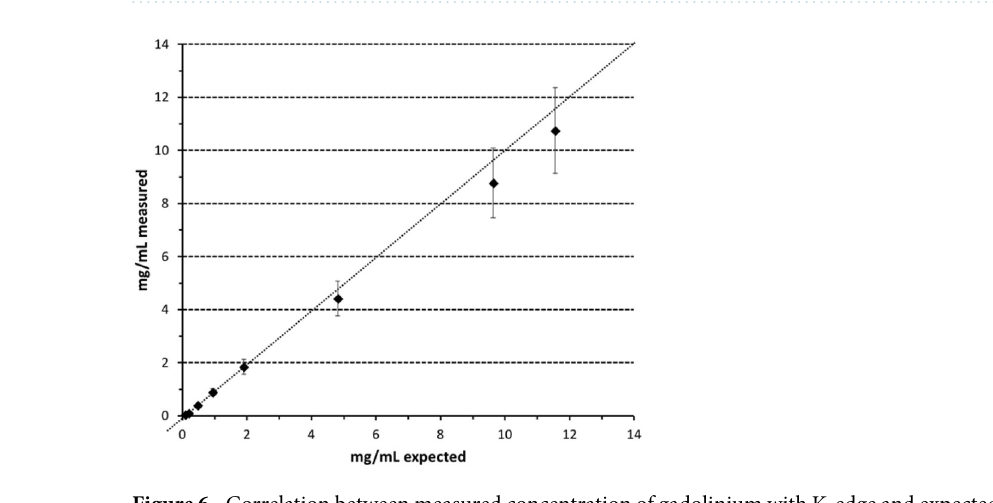
Figure 5. (Left) SPCCT gadolinium K-edge image of a phantom consisting of GdF 3 suspensions of various gadolinium concentrations from 2 mg/mL up to 20 mg/mL (12 mM to 120 mM respectively) (Right) Same phantom observed with SPCCT conventional image.